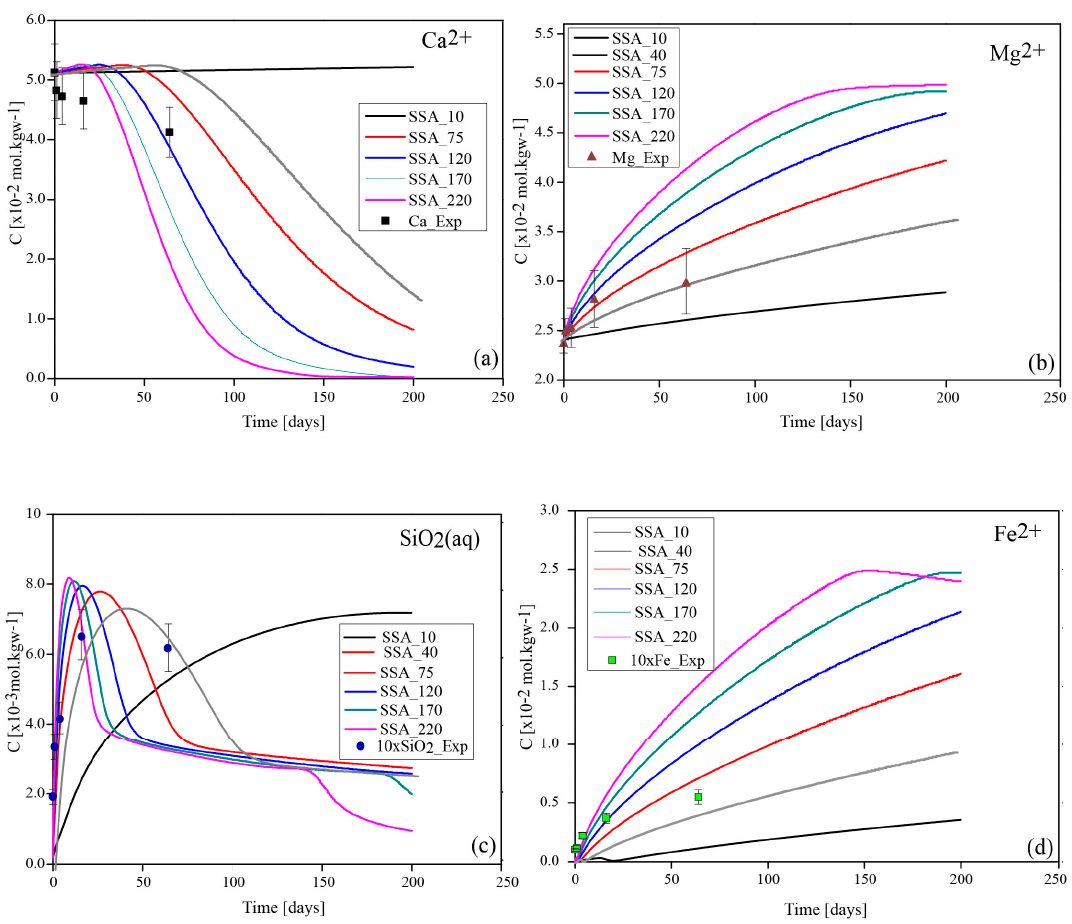
Figure 8. Variation in the solution composition with time compared to the experimental data. ( a ) Ca 2 + ; ( b ) Mg 2 + ; ( c ) SiO 2 (aq); ( d ) Fe 2 +